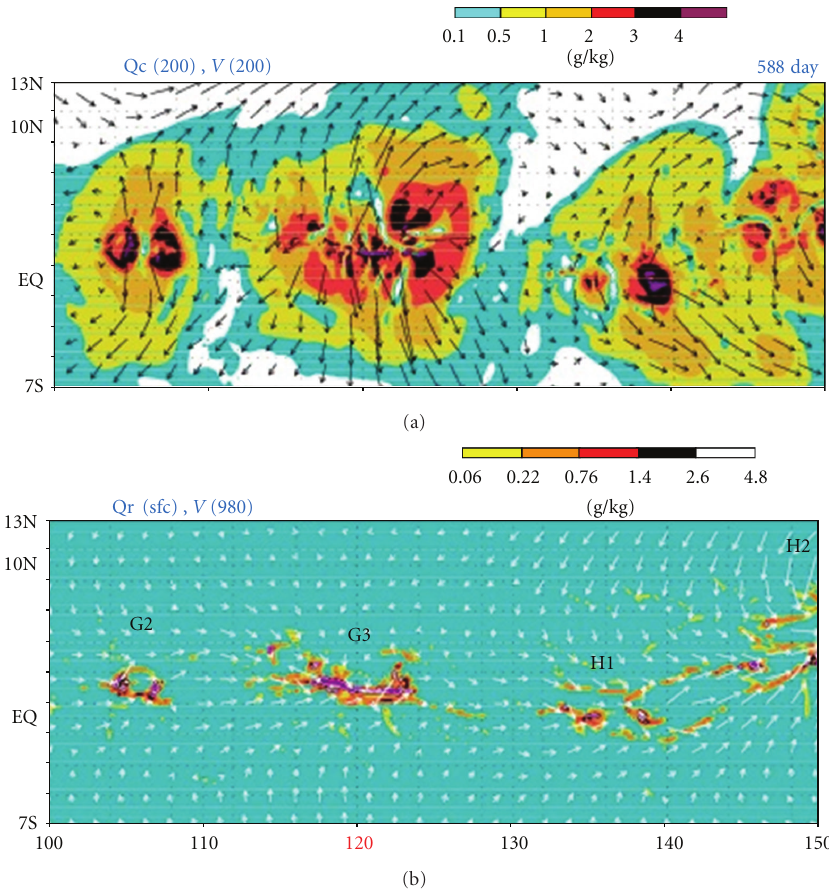
Figure 13: Same as Figure 12 but at 588 day. Cloud clusters G2, G3, H1, and H2 are